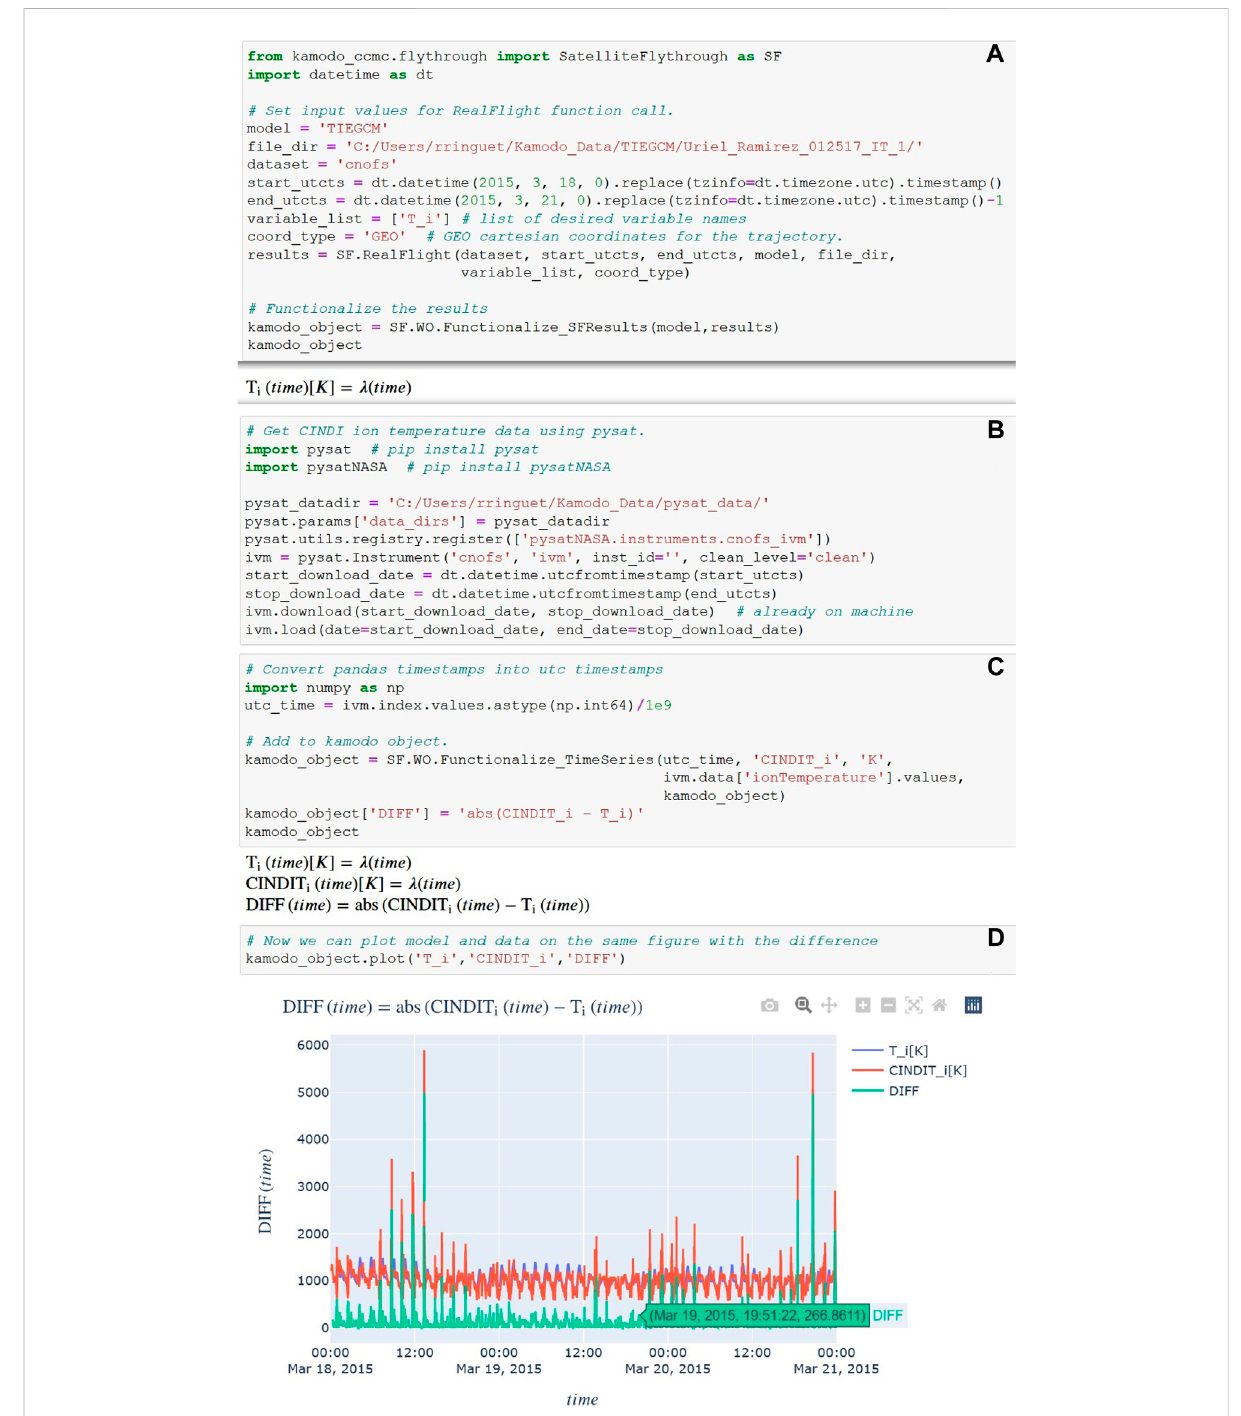
FIGURE 9 Example of model-data comparison using pysat and Kamodo. The fi rst block (A) is identical to the fi rst block of Figure 7. The second block (B) proceedstousepysattoretrievethesamedataasinFigure7,butappliesthedatacleaningroutinesforthedataimplementedinpysat.Thenextblock (C) convertsthetimestoUTCtimestamps,functionalizesthedata,andaddsthefunctionalizeddatatotheexistingKamodoobject.Theoutputofthe fi nal block (D) is similar to that of Figure 7, but now contains the cleaned observational data instead of the raw